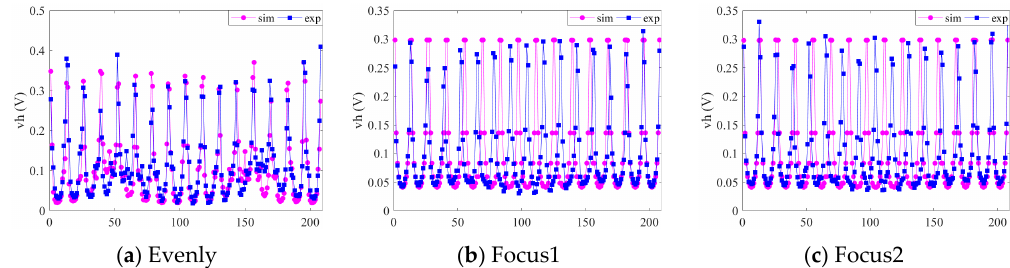
Figure 10. Comparison of experimental and simulated voltage waveforms.